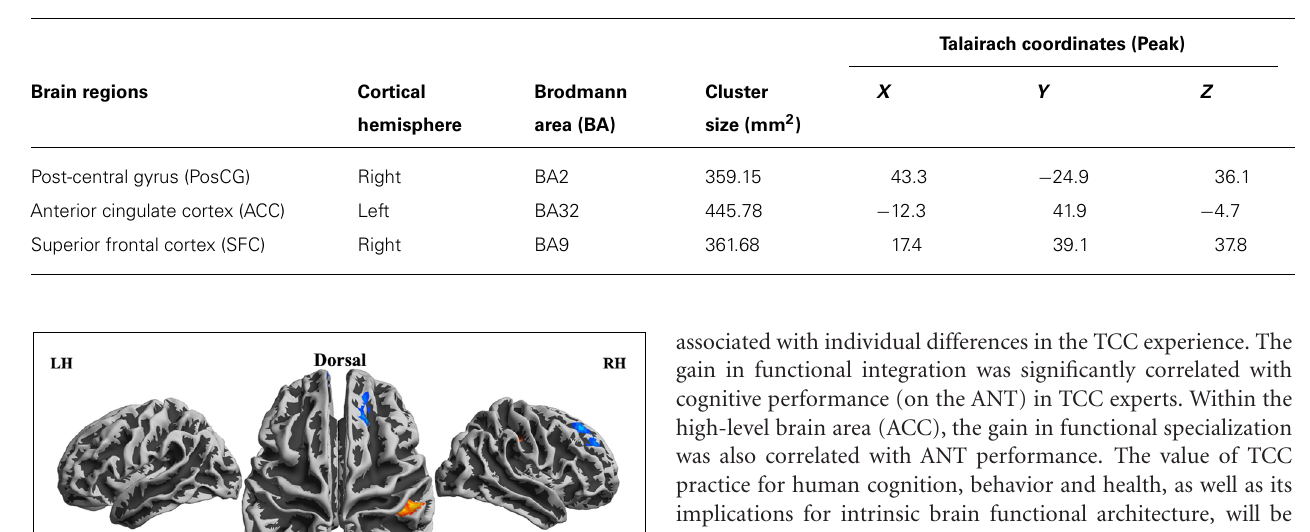
Table 2 | Cortical areas with significant changes in functional homogeneity induced byTCC practice.